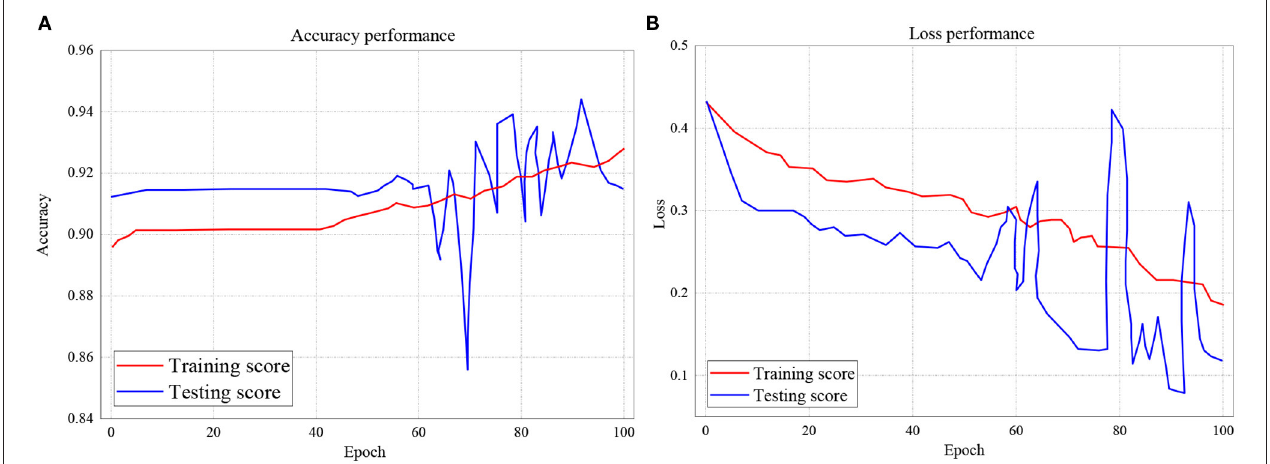
FIGURE 11 | (A,B) Performance accuracy and loss of Training and Testing Scores for RNN.